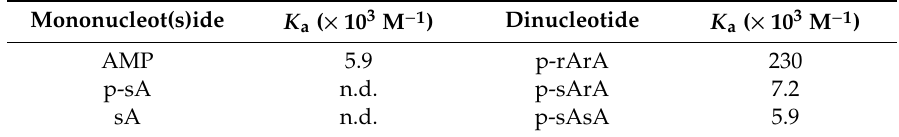
AMP is adenosine monophosphate; p-sA is 5’ phosphorylated SNA adenosine; rA is adenosine. n.d. indicates that binding was not detected.